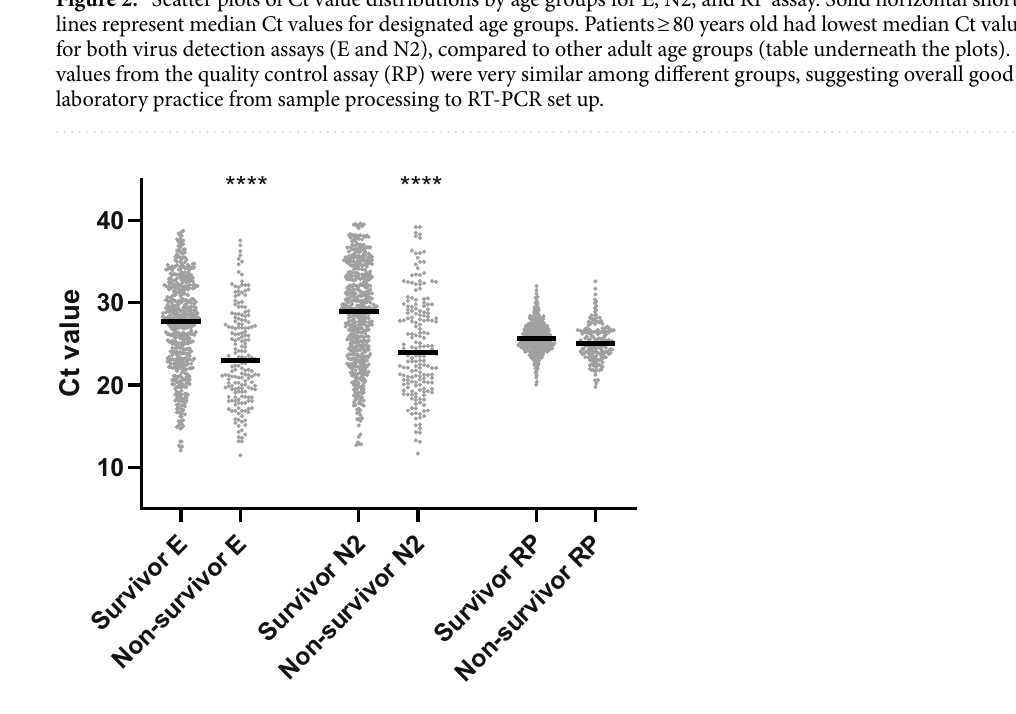
Figure 3. Ct value distribution by survival. Solid black lines represent median Ct values for designated age groups. Statistical significance for comparison between survivor and non-survivor was labeled by ****p <